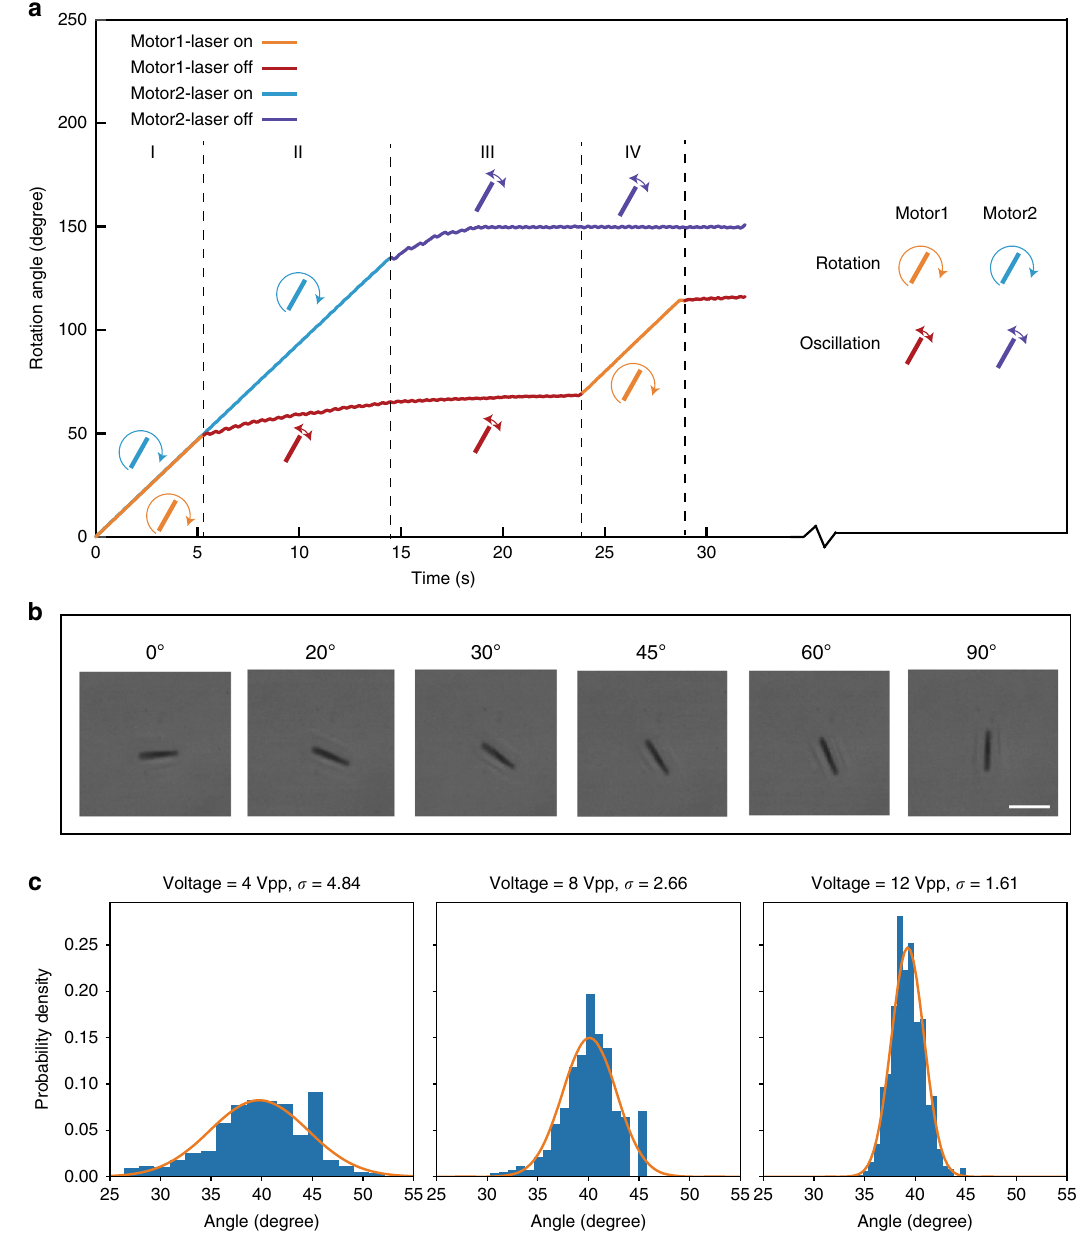
Fig. 5 a Independent control of two stepper micromotors in the same E- fi eld. The micromotors are both driven by a rotating E- fi eld with f ¼ 100 kHzand f ¼ 1 : 49 Hzat 13 Vpp . Digital light projecting (DLP) system projects light on each micromotor independently at an intensity of 1 2 ~50 mW cm − 2 . b Rotation of a micromotor to designated angular positions like a stepper motor by stopping the rotation of the AC E- fi eld at speci fi c angle ( f 1 = 100 kHz, V = 10 Vpp, laser intensity = 127 mWcm − 2 ), scale bar 10 μ m. c Angle fl uctuation around a designated angle at different voltages (frequency = 100 kHz). Probability density is fi tted by normal